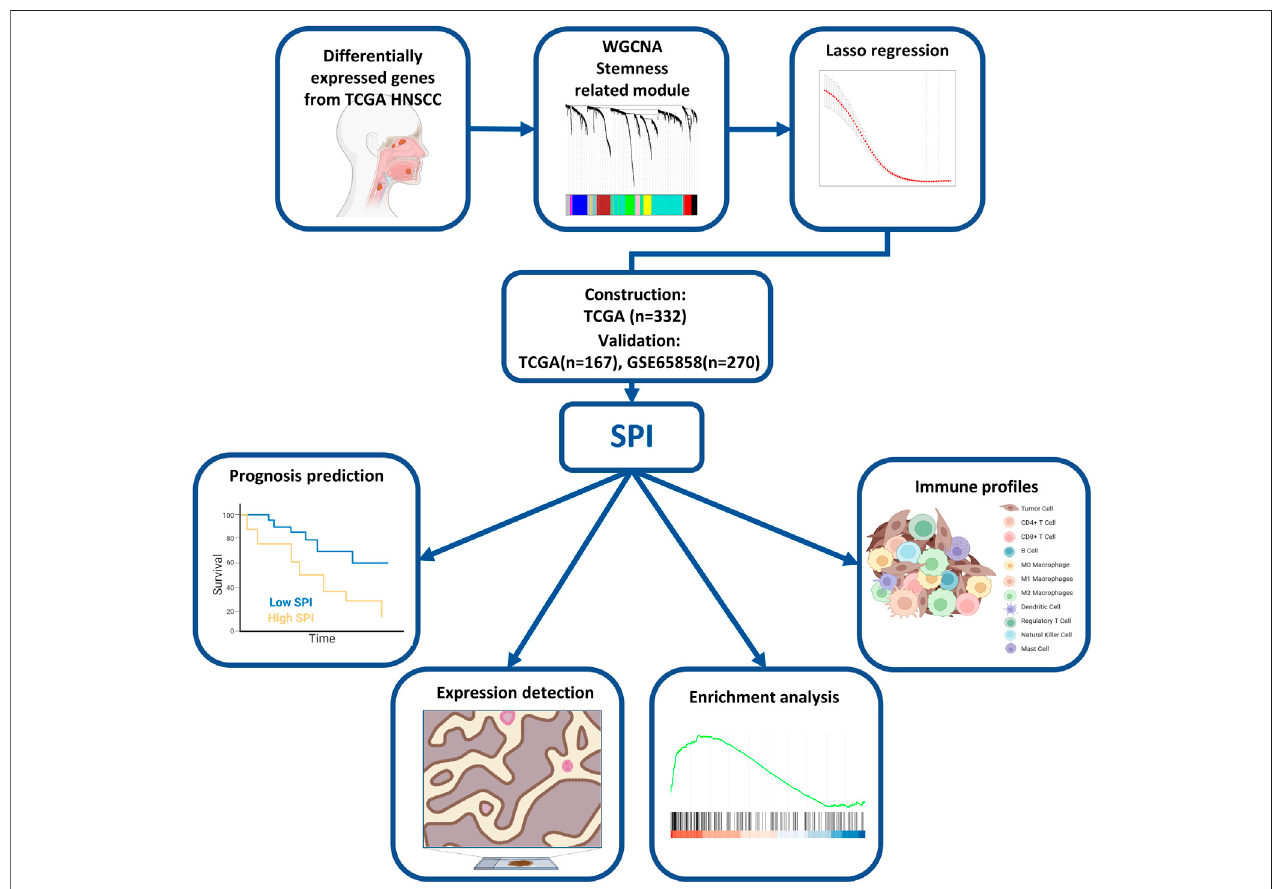
FIGURE 1 | Flowchart of the